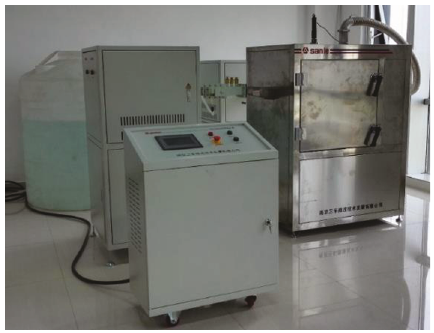
Figure 1: Microwave heating system.